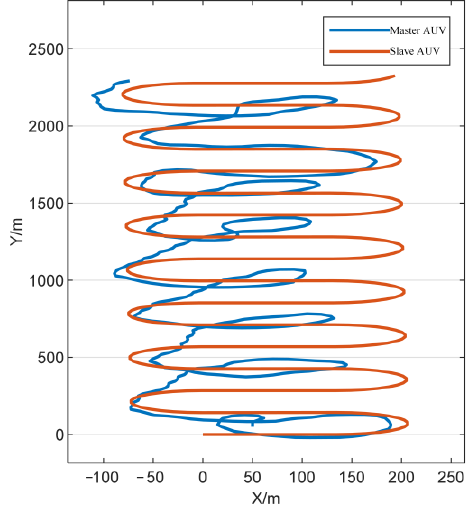
Figure 13. Paths of the master and slave AUVs.